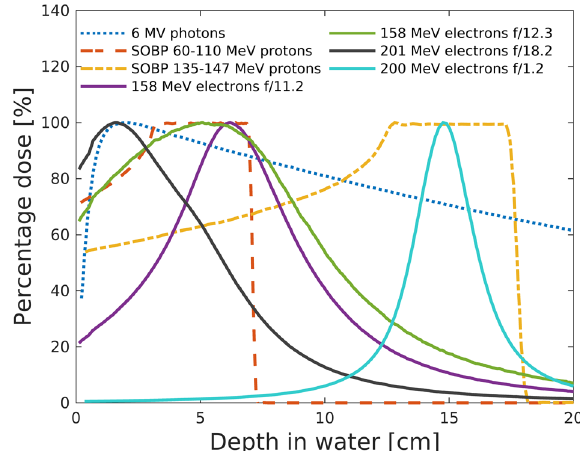
Fig. 1 Simulations of axial dose distributions in a water phantom for different beam geometries and energies. (i) Collimated 6 MV photons, (ii) 60 – 110 MeV and (iii) 135 – 147 MeV protons (SOBP), 158 MeV electron beams focused in the horizontal plane with (iv) f/ 11.2 and (v) f/ 12.3 (vi)